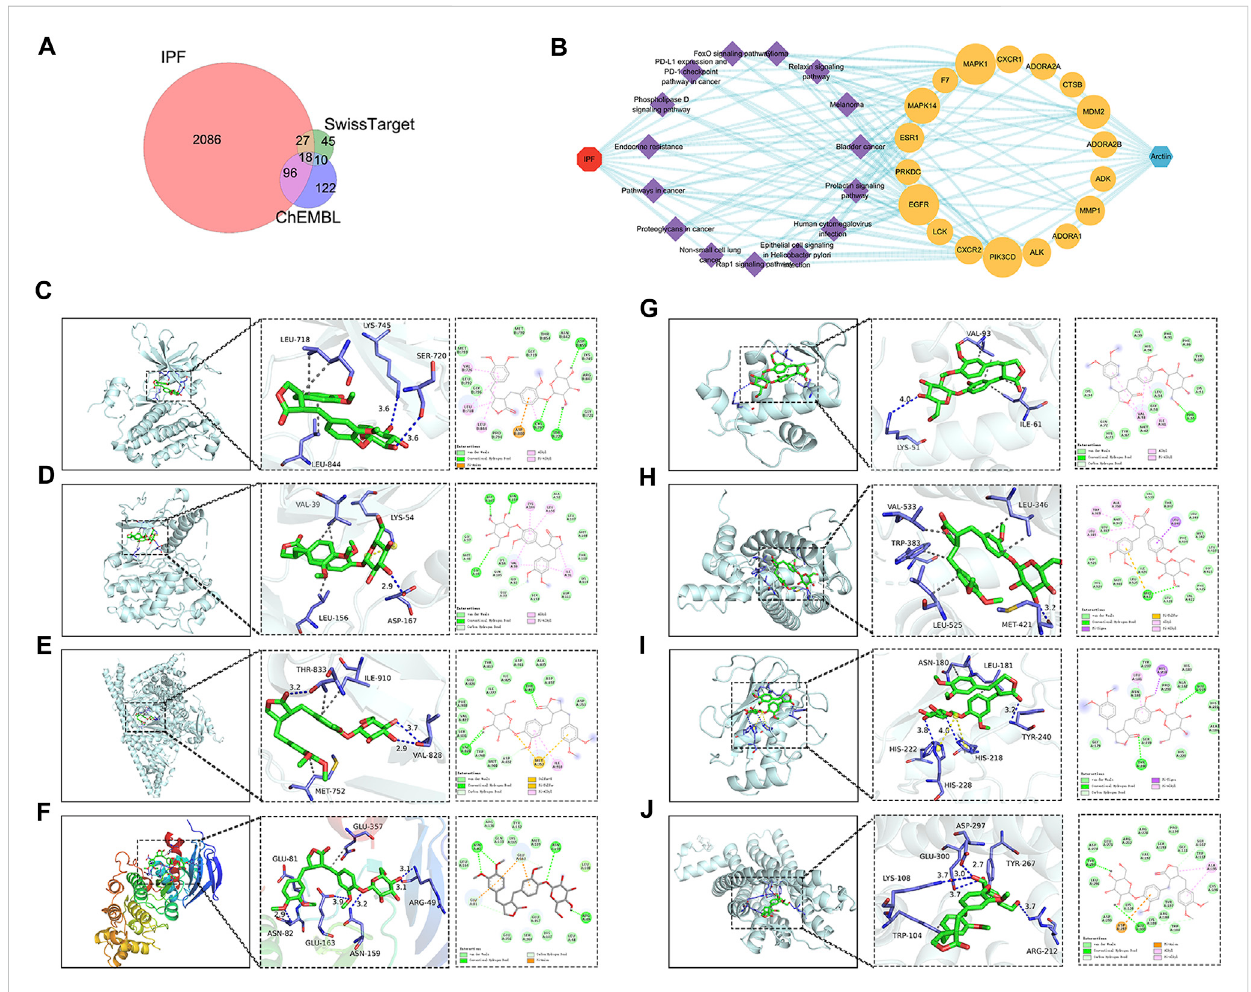
FIGURE 4 Network construction of arctiin (ARC) related to idiopathic pulmonary fi brosis (IPF) and molecular docking. (A) Venn diagram summarizing the intersected gene targets between ARC and the IPF. (B) ARC-target-pathway-IPF network. (C – J) ARC molecular docking and the top 8 target proteins related to IPF after visualization.